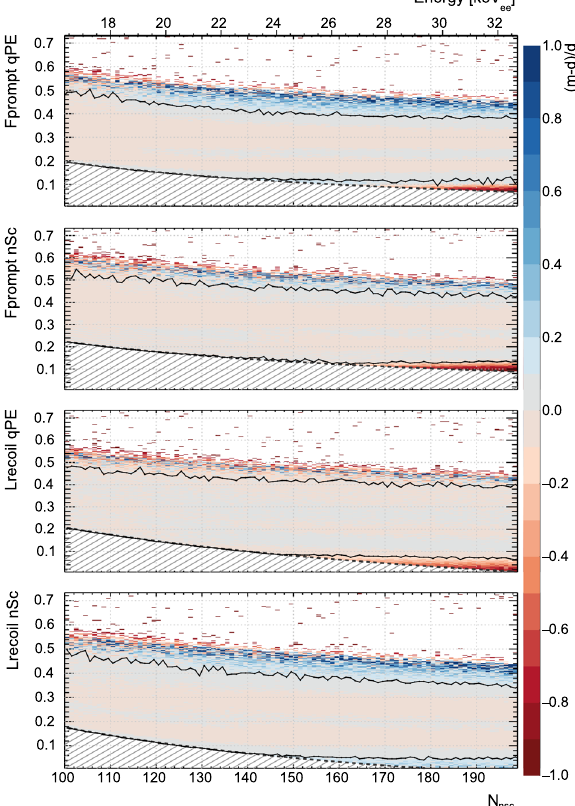
Fig. 3 The relative difference, (model-data)/data, for each of the four PSD parameters. The only significant deviations between model and data are at the edge of the distributions, where several systematic effects bias the event count (see Sect. 5.4). The black contour shows, for each N nsc slice, the first bin when going from the center of the population to higher/lower values of the PP where the absolute value of the difference between model and data is more than 10%